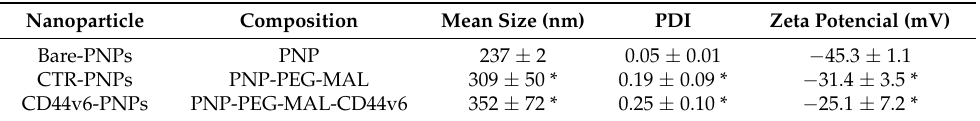
Table 1. Clickable surface-engineering strategy allows efficient ligand bioconjugation. Particle size (nm), polydispersity index (PDI), and zeta potential (mV) of PNPs before and after conjugation